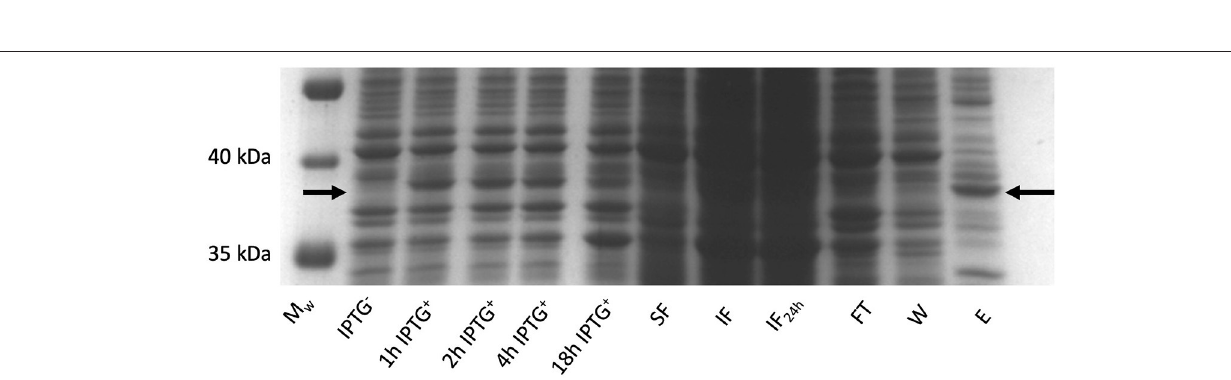
phosphate buffer solution mixed with dithizone solution. The zinc concentration was interpolated from a standard curve plotted using various Zn 2 +